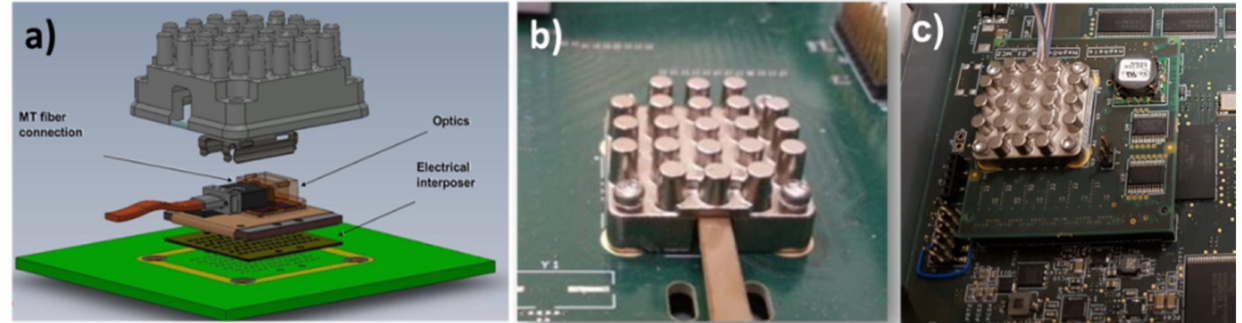
Figure 2. Finisar midboard optical transceiver module package: ( a ) schematic view of Finisar “BOA” module [3], ( b ) photo of Finisar BOA module assembled directly onto a PCB, ( c ) photo of Finisar BOA module on a pluggable small mezzanine card [12].